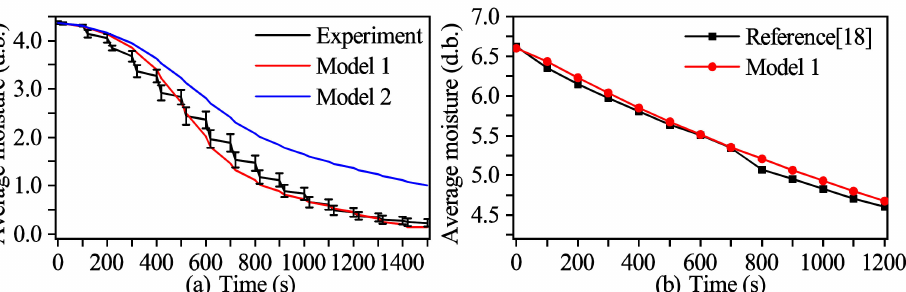
Figure 4. Average moisture content on dry basis. ( a ) Simulation results compared with the experimental datum. ( b ) Simula- tion results compared with the experimental datum in